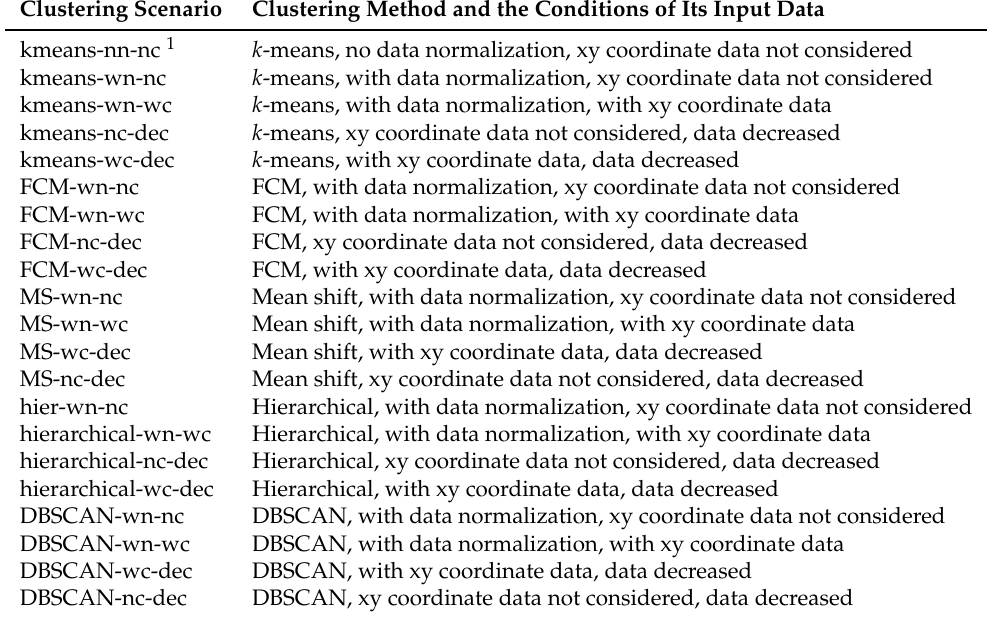
Table 2. The clustering scenarios evaluated in this